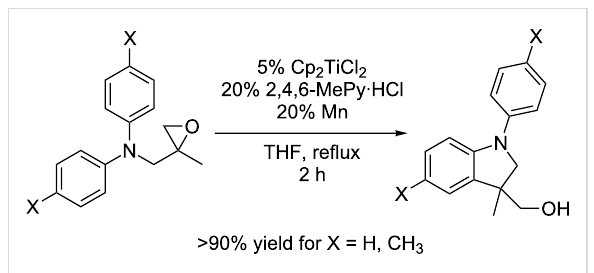
Scheme 1: Experimental results for the radical arylation of